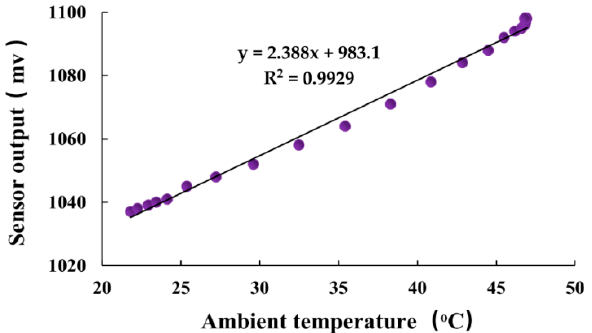
Figure 5. Relationship between the sensor output and ambient temperature.